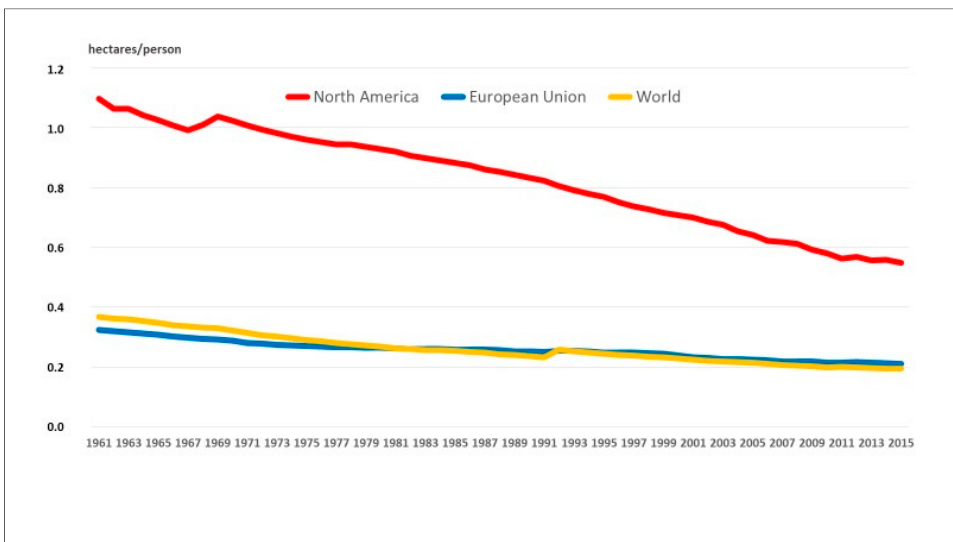
Figure 1. The arable land per person has been continuously reduced in the recent past. Arable land in hectares per person from 1961–2015 for North America, the European Union, and worldwide, according to World Bank [2].